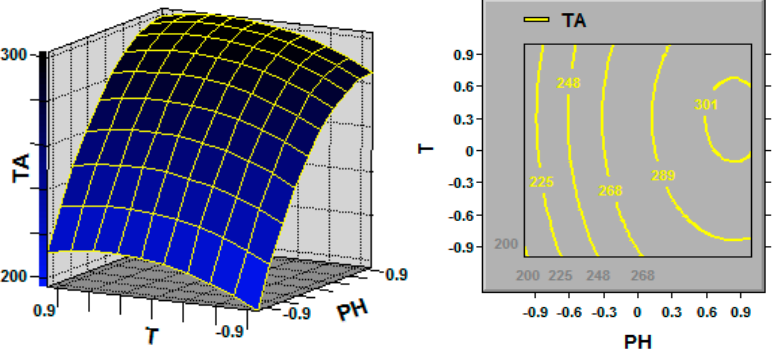
Figure 2. Response surface curve ( left ) and contour plot ( right ) for triterpene acid (TA; mg/L) production illustrating the interaction between the initial pH (pH) and temperature (T) at the coded levels. Fixed level: DO = 0.